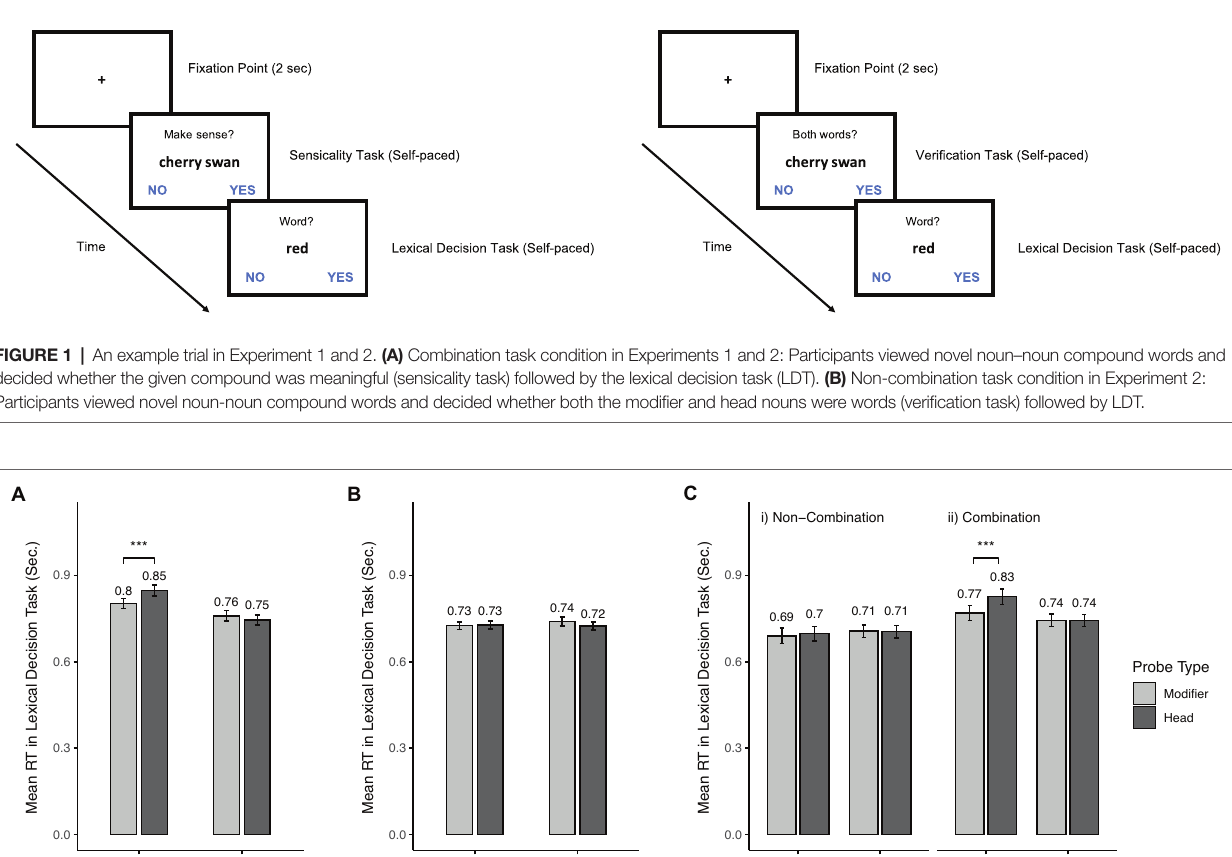
FIGURE 2 | Mean response time (RT) in the lexical decision task (LDT) by conditions in Experiment 1 and 2. (A) Mean RT in the LDT by combinatorial type and probe type in Experiment 1, (B) Mean RT of the baseline condition in the LDT by combinatorial type and probe type in Experiment 1, and (C) Mean RT in the LDT by task type, combinatorial type, and probe type in Experiment 2. Error bars indicate standard errors. *** p <